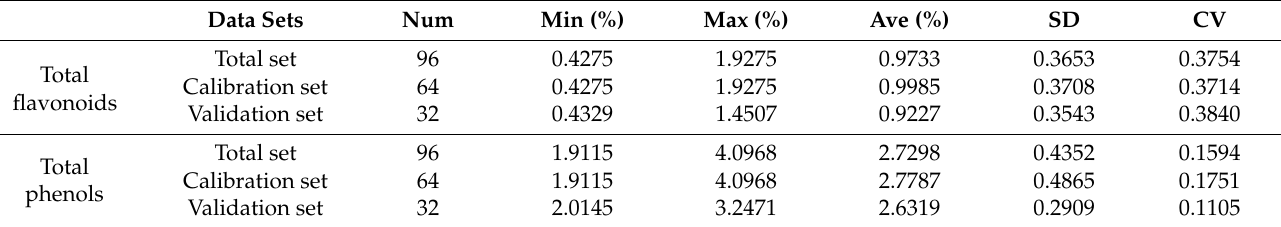
Table 2. Data characteristics of total flavonoids and total phenols.